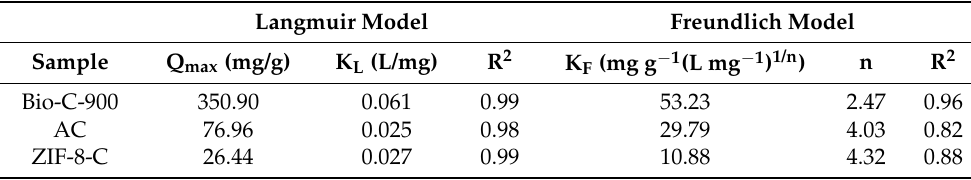
Figure 6. ( a ) Adsorption kinetics curves of all materials for SMX in this study; ( b ) The corresponding pseudo-second-order adsorption kinetic model and Elovich kinetic model were fitted. Reaction con- ditions: initial concentration of SMX = 10 mg/L, reaction volume = 50 mL, catalyst dosage = 4.5 mg, initial solution pH = 7, temperature = 25 °C, reaction time = 45 min. Table 4. Langmuir and Freundlich adsorption isotherm model. Table 4. Langmuir and Freundlich adsorption isotherm model.